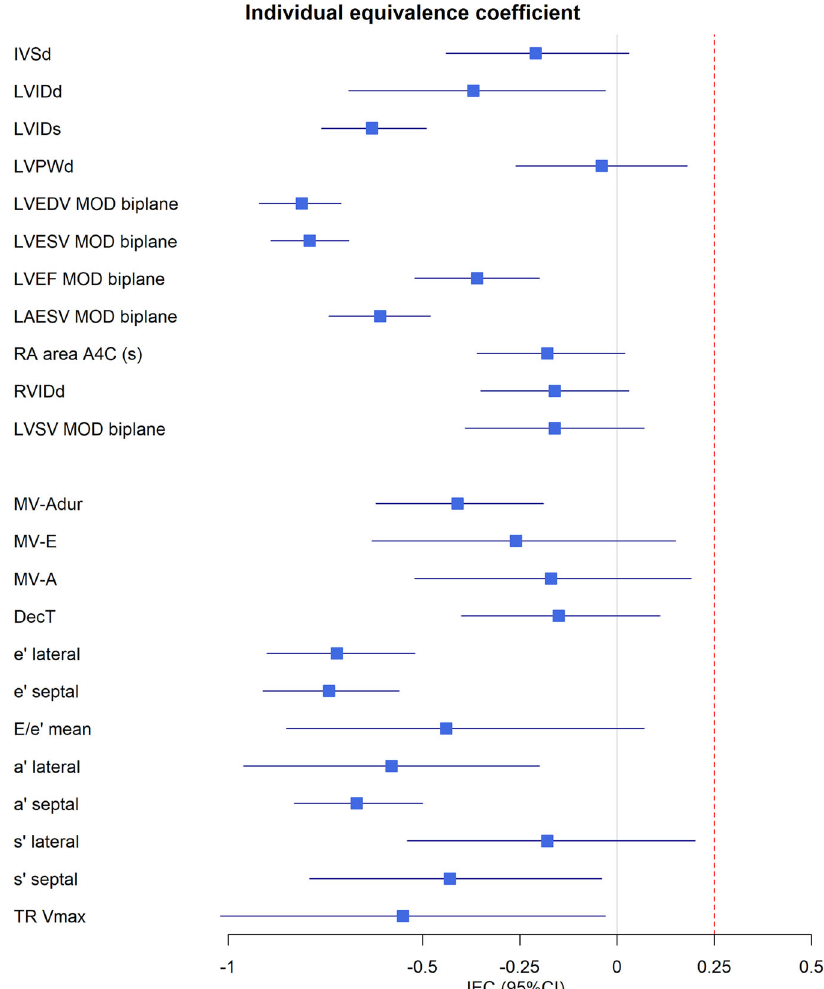
Fig. 1 | Forest plot showing the individual equivalence coef fi cients for twenty- three parameters. The blue box depicts the average individual equivalence coef- fi cient. The error bars depict the upper and lower limits of the 95% con fi dence interval. The red line indicates the pre-determined non-inferiority criterion of 0.25 for the upper bound of the 95% con fi dence interval. Abbreviations and N (number of studies): a ’ lateral ( N =408); a ’ septal ( N =430); e ’ lateral ( N =458); e ’ septal ( N =490); E/e ’ ( N =388); DecT, deceleration time of early diastolic MV transmitral fl ow(N=446);IVSd,interventricularseptaldiameterenddiastolic( N =547);LAESV MODbiplane,leftatrialendsystolicvolumebiplanecalculationbasedonmethodof discs ( N =507); LVEDV MOD biplane, left ventricular end diastolic volume biplane calculation based on method of discs( N =534);LVEF MODbiplane, left ventricular